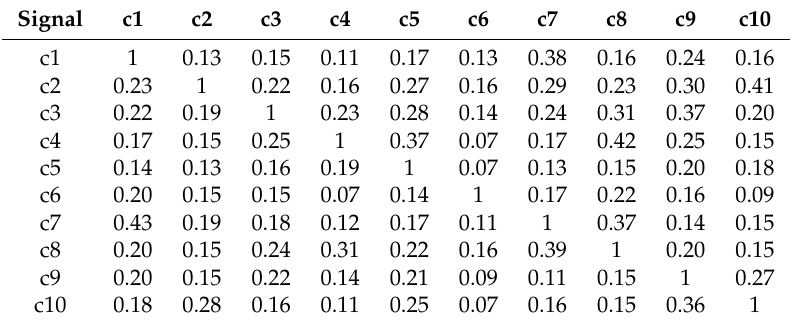
Table 2. The normalized cross correlation and autocorrelation coefficients of each